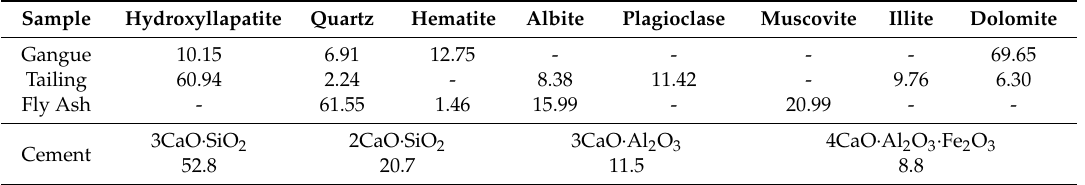
Table 2. Mineral compositions of the aggregate (%).